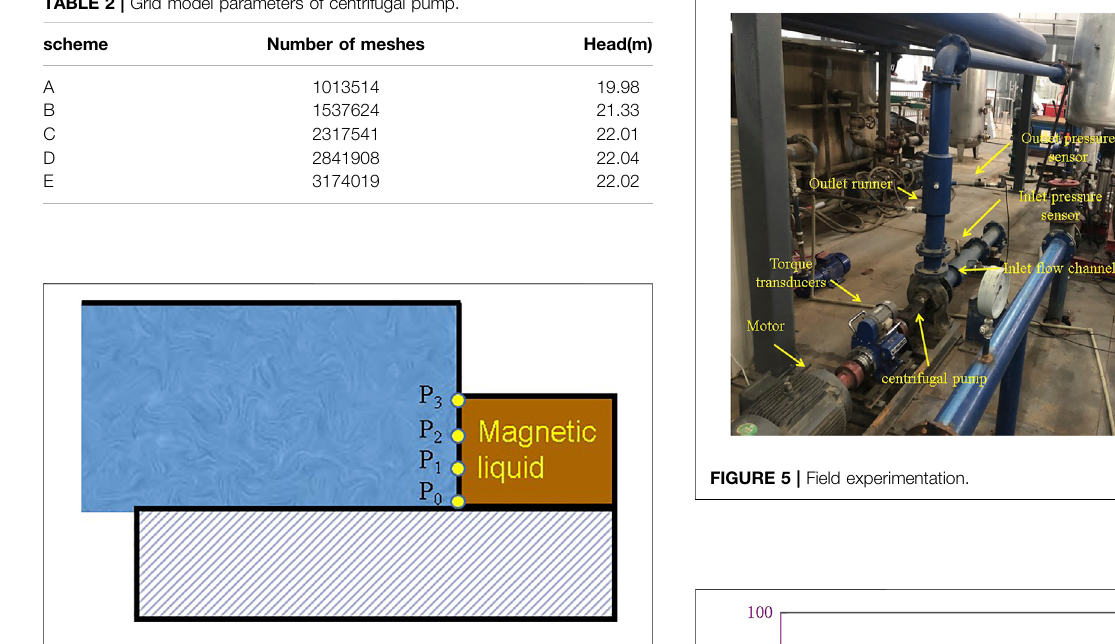
FIGURE 4 | Position of monitoring point.